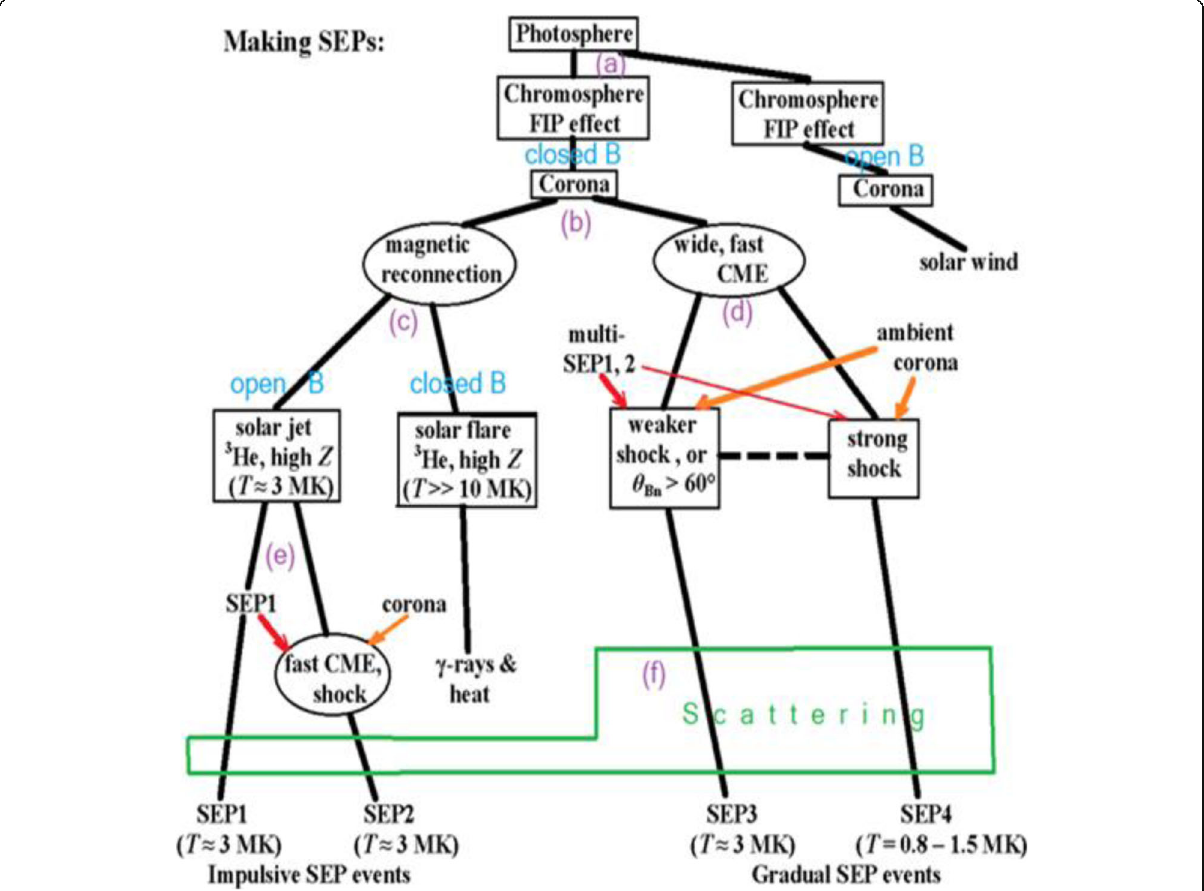
Fig. 28 Possible reconciliation between the two-class paradigm of the early 1900s and the puzzling SEP observations from Wind, ACE, and STER EO. The SEPs are grouped into four sub-classes according to their acceleration locations and the contributions of relevant physical processes (taken from Reames 2020). a Elements experience different FIP processing on open and closed field lines. b SEPs are accelerated in magnetic reconnection regions or by CME shocks. c SEPs enriched in 3 He and heavy ions escape along open field lines associated with solar jets, and not from closed field lines associated with solar flares. d Weaker CME-driven shocks preferentially accelerate residual suprathermal material left over from multiple jets, while the stronger CME shocks accelerate ambient coronal material. e Fast CMEs associated with jets also accelerate suprathermal jet-accelerated material. f Rigidity-dependent trapping near CME shocks or scattering in the corona and the IP medium modifies heavy ion abundances and energy spectra in large gradual SEP events. In some large events, self-generated waves can enhance particle trapping and increase the acceleration efficiencies of the CME